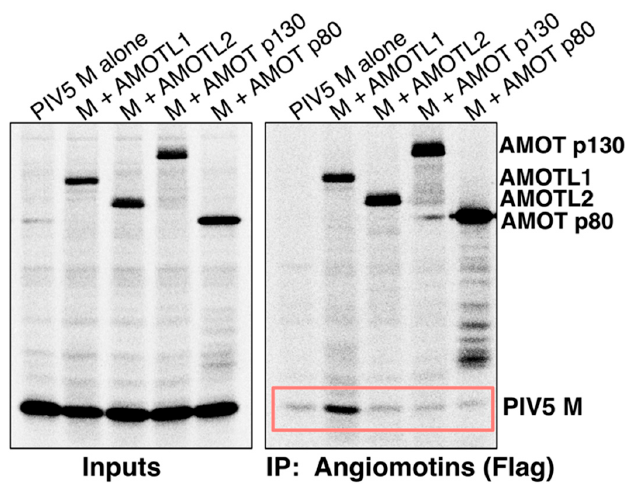
Figure 2. PIV5 M protein binds to AMOTL1, but not to AMOT or AMOTL2. 293T cells were transfected to produce PIV5 M protein together with the indicated Flag-tagged angiomotins. Proteins synthesized in the transfected cells were metabolically labeled with 35 S, and cells were lysed in a solution containing 0.5% NP-40. Immunoprecipitation was carried out using a combination of anti-Flag and anti-PIV5 M antibodies (left), or using Flag antibody only (right). Proteins were fractionated on SDS gels and detected using a phosphorimager. Boxed region denotes M co-precipitation.